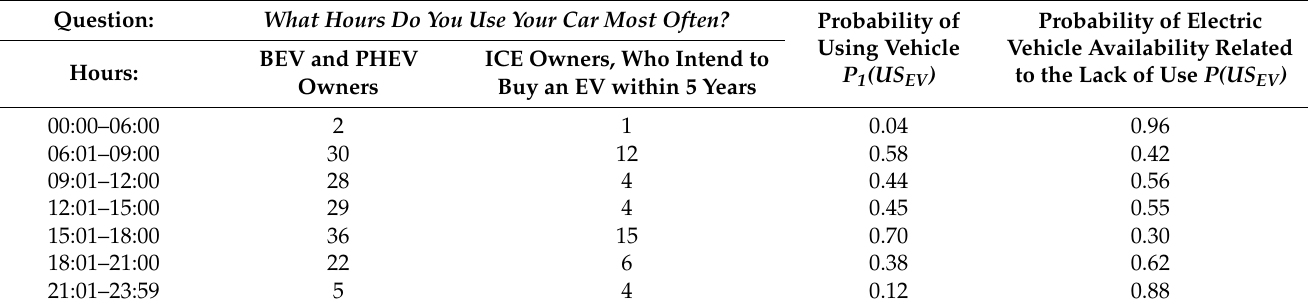
Table 3. Calculation of probability values P(US EV ) .